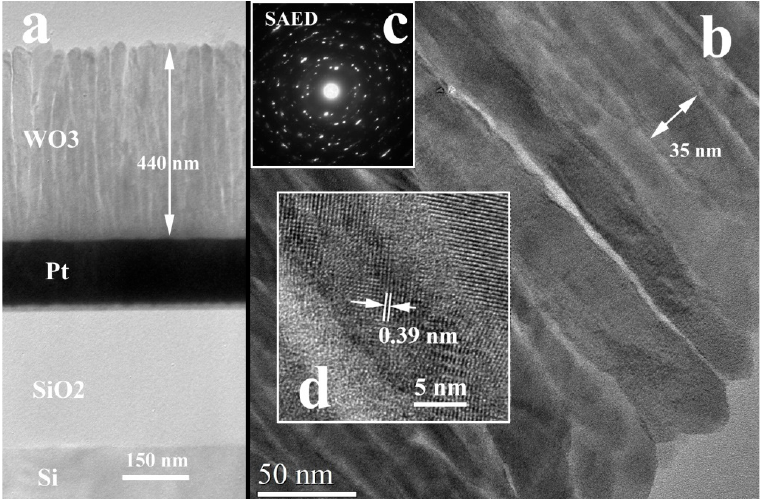
Figure 4. XTEM images of the WO 3 film deposited on Pt/SiO 2 /Si substrate using the 1064 nm laser radiation; ( a )—Low magnification TEM image of the sample cross ‐ section; ( b )—crystallized columnar grain structure of the film; ( c )—SAED of the columnar grain structure; ( d )—HRTEM detail of the WO 3 columnar grain structure.